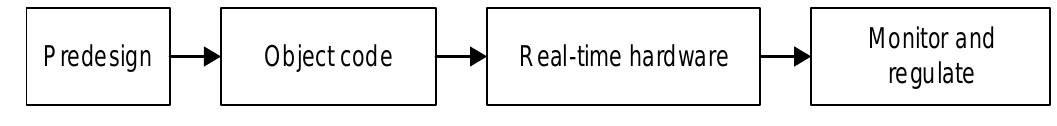
Figure 2. The development process of dSPACE.